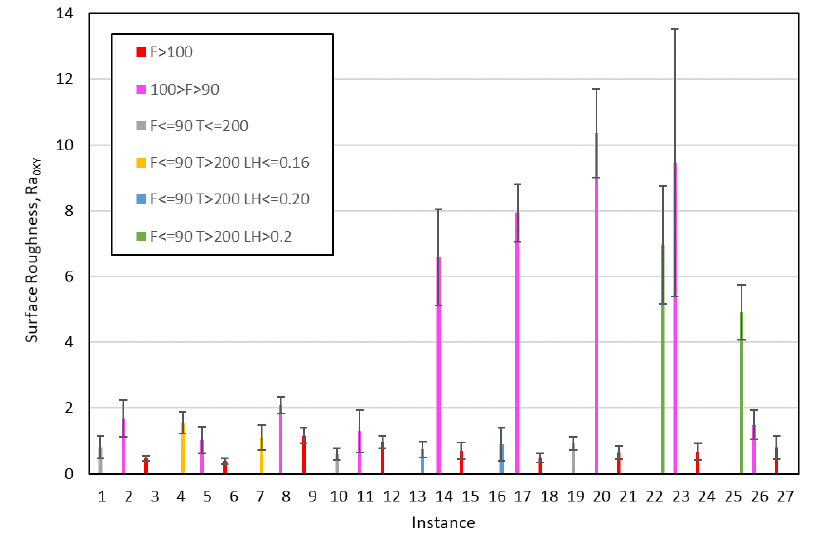
Figure 11. Mean values and standard deviation for R a0XY ; each color represents a leaf of the decision tree: pink, yellow and green instances belong to class 2; the rest of color belong to class 1 (F: Flow; T: Temperature; LH: layer height).